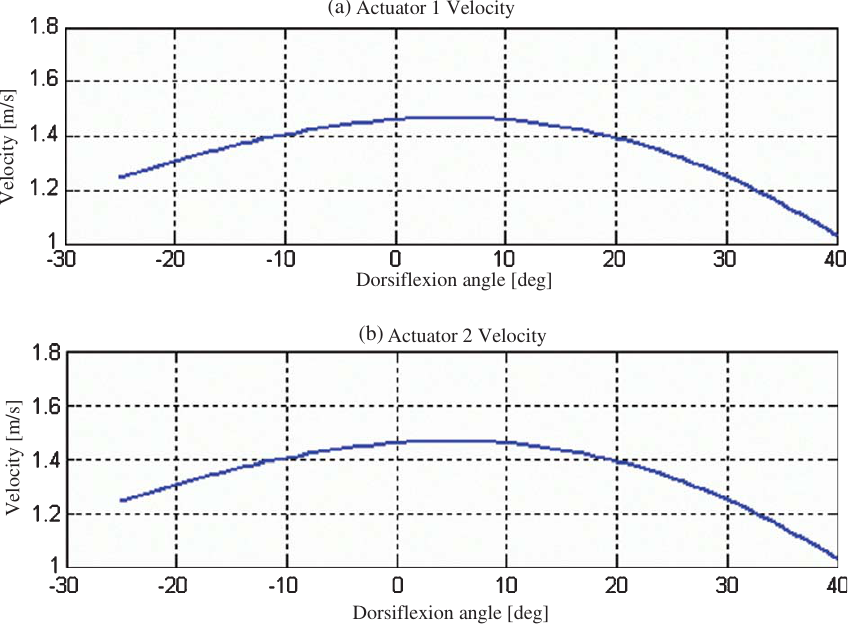
Fig. 13. Actuators velocity in a pure dorsiflexion